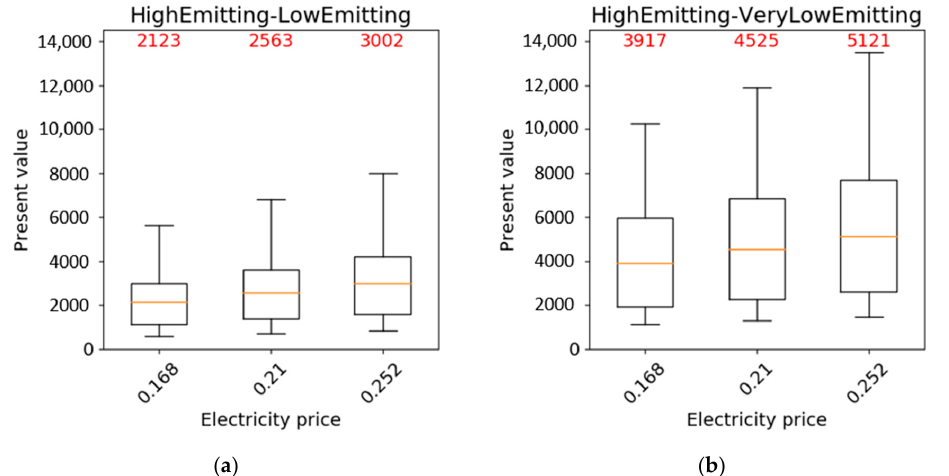
Figure 5. Present values calculated with different electricity prices. ( a ) Scenario HE − LE. ( b ) Scenario HE − VLE.